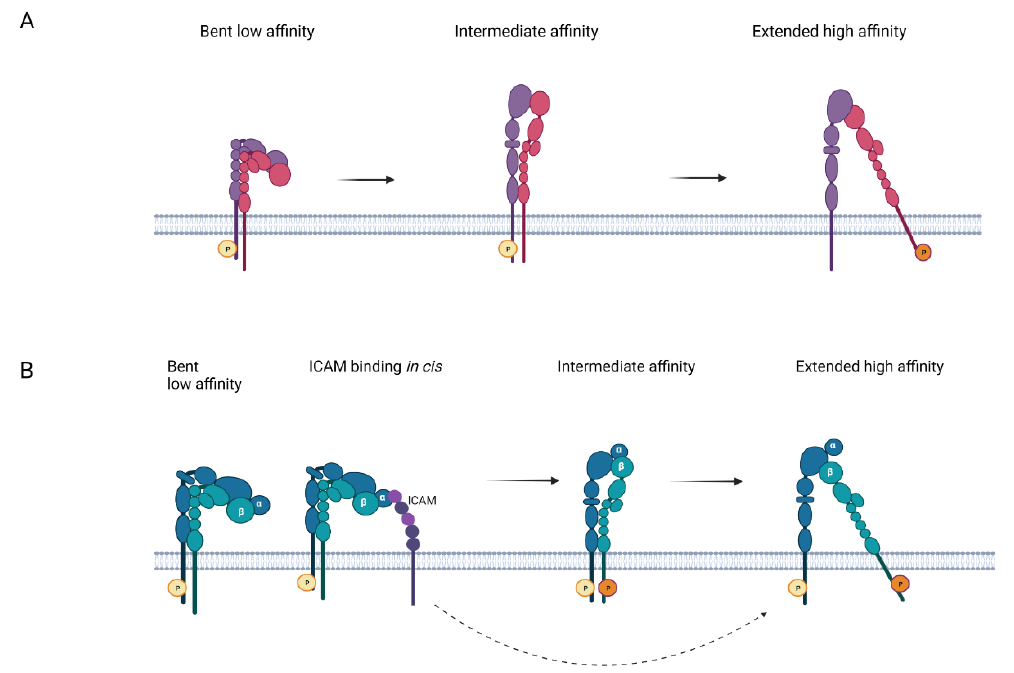
Figure 1. Schematic structures of resting and activated integrins. ( A ) an integrin with no I-domain, an example of which could be α 4 β 1. In the resting integrin, the α -chain is phosphorylated, but not the β -chain. The α -chain in blue and the β -chain in red. ( B ), LFA-1, which contains an I-domain. Part of the molecules at the resting stage are bound to an ICAM in cis. The α -chain is phosphorylated on S1140. Initial activation results in the closed, extended form. The fully activated integrin is phosphorylated both on S1140 in the α - chain and T758 in the β -chain. P shows the phosphorylations.